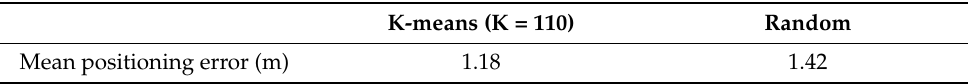
Table 4. Comparison of validation sets obtained by different methods on the Alcala Tutorial 2017 dataset.